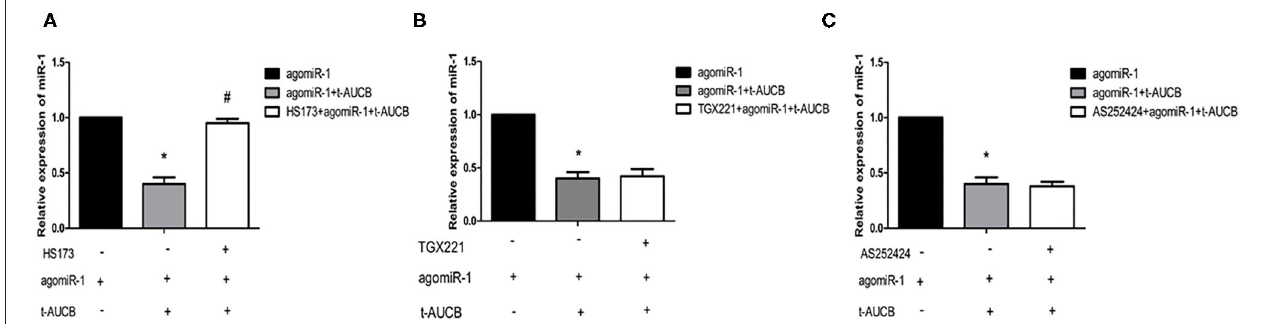
FIGURE 3 | Effects of three PI3K subtypes on t-AUCB-mediated regulation of miR-1. Primary neonatal mouse cardiomyocytes were treated with PI3K α inhibitor HS173, PI3K β inhibitor GX221, and PI3K γ inhibitor AS252424 for 6h, and then the cells were transfected with micrONTM mmu-miR-1a-3p croRNA-1 (agomiR-1), and treated with t-AUCB. The expression of miR-1 was detected. (A) T-AUCB significantly decreased miR-1 levels, and HS173 significantly reduced this effect. (B) GX221 was not involved in t-AUCB-mediated regulation of miR-1. (C) AS252424 were not involved in t-AUCB-mediated regulation of miR-1. Compared with the agomiR-1 group, * P < 0.05; compared with the agomiR-1 + t-AUCB group, # P < 0.05; all n = 6.